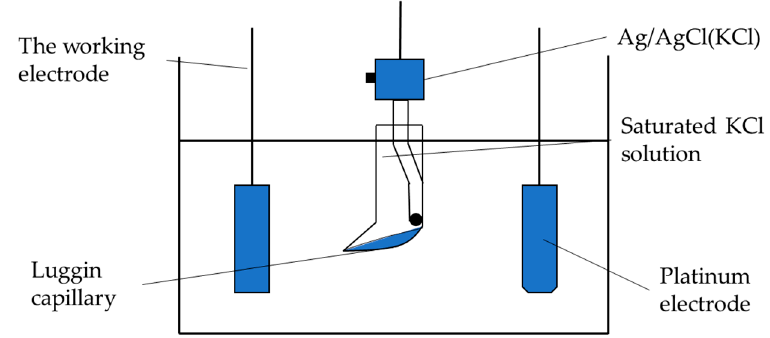
Figure 2. Electrochemical detection device schematic.